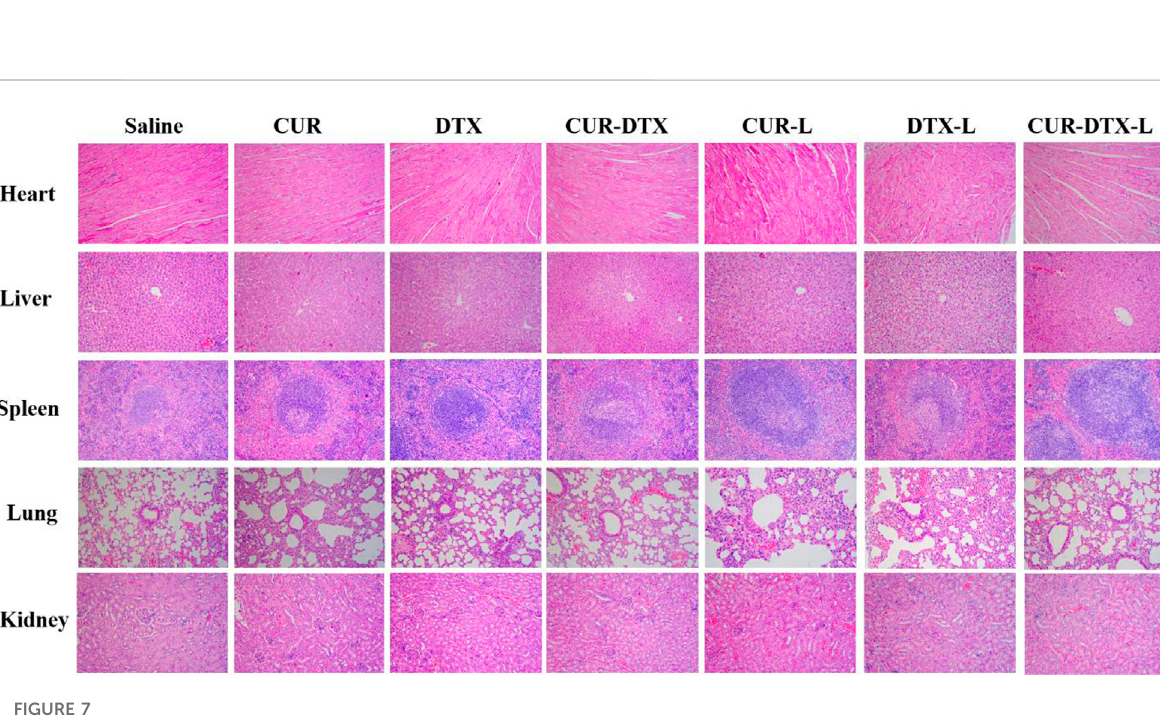
FIGURE 7 H and E staining images of the heart, liver, spleen, lung, liver, and kidney (magni fi cation